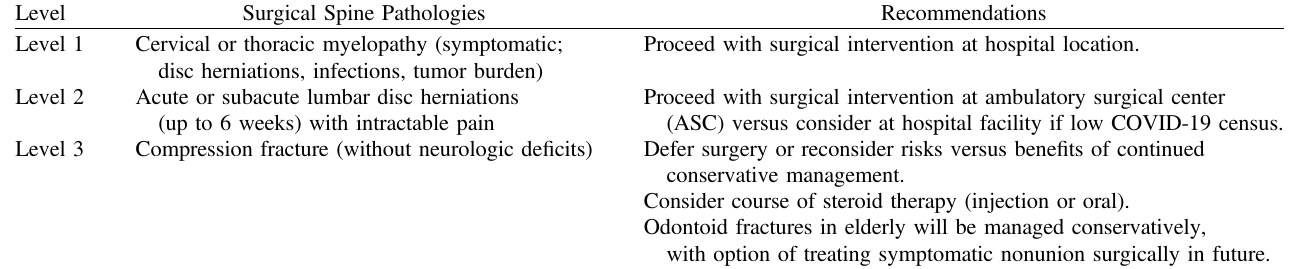
Table 4. Examples of triaging spine surgery in the COVID-19 era [44]. Level Surgical Spine Pathologies